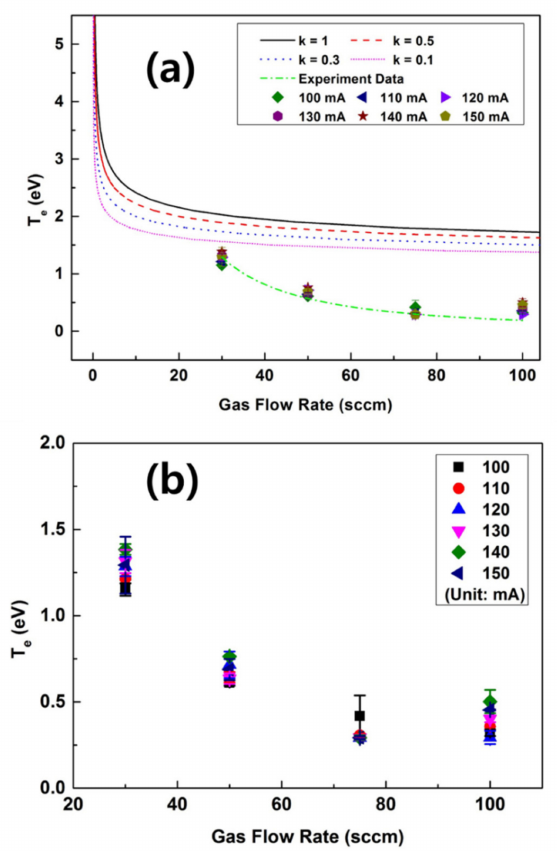
Figure 5. The T e profiles according to gas flow rates: ( a ) for comparing numerical calculations with the geometry factor ( k ) = 0.1–1 ( z : 0 cm, at a center of plasma source) and experimental results ( z : 3 cm, at plasma jet: 3 cm from a nozzle throat) and ( b ) experimental results with various discharge currents in